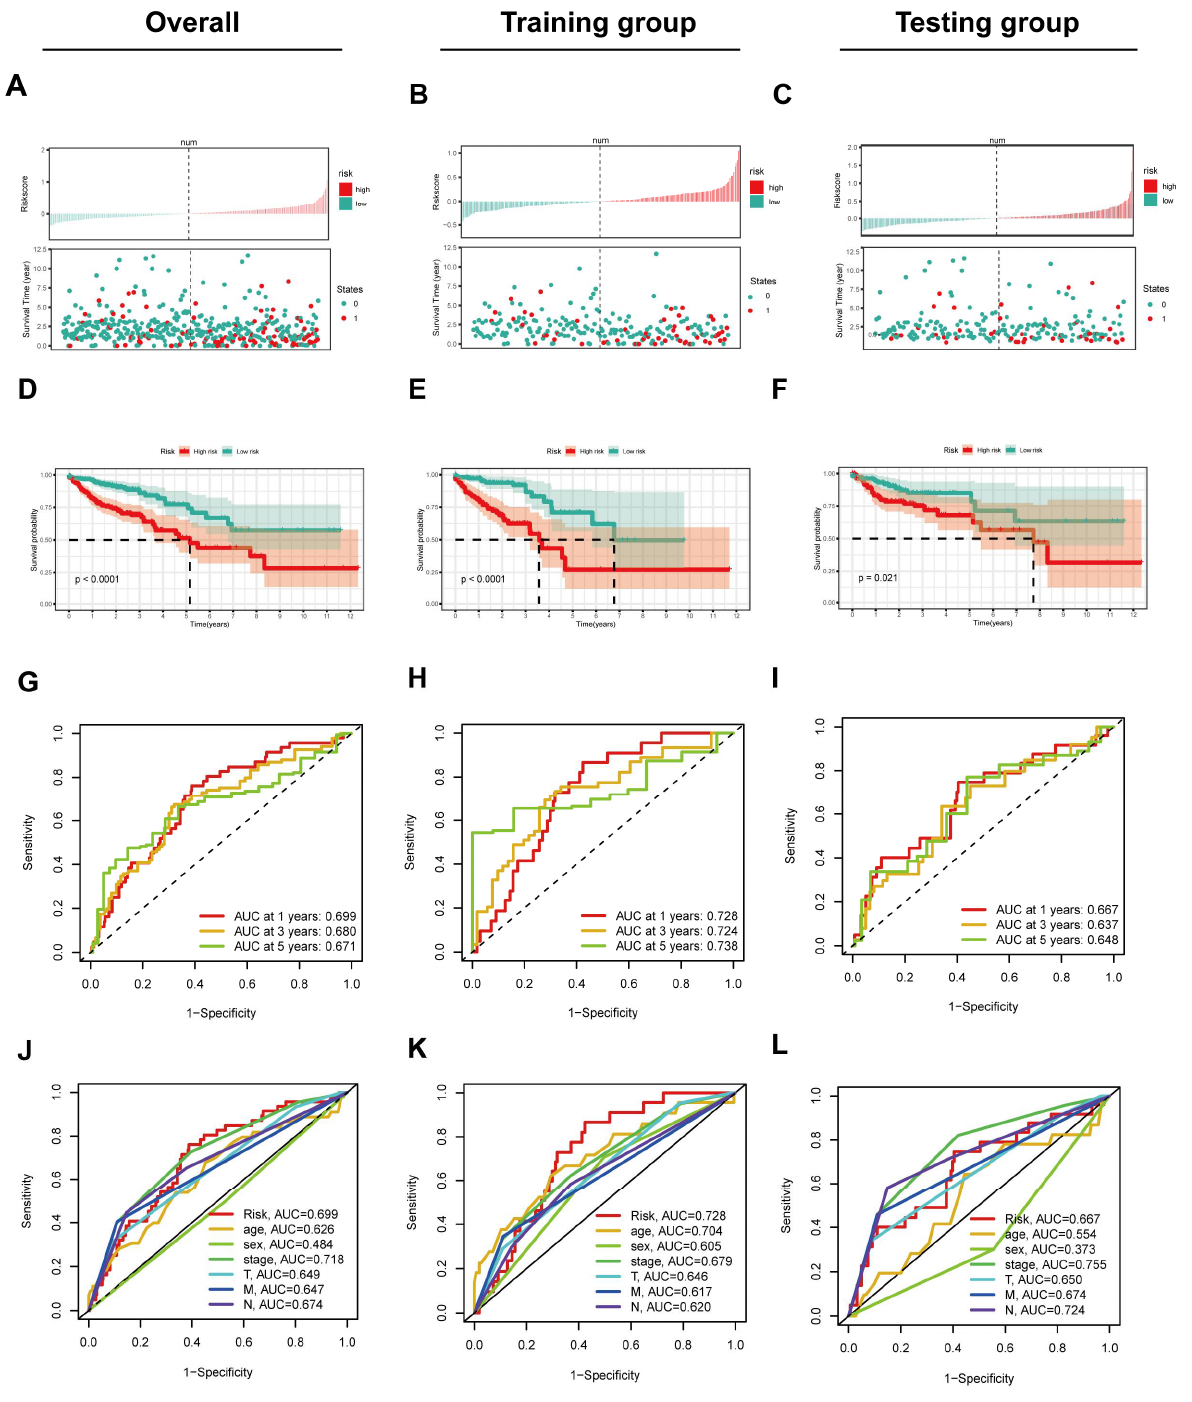
Figure 4. Validation of the necroptosis-related lncRNA model in the overall groups, the training group and the testing. ( A – C ) The distribution of the risk scores and the distributions of OS status in the overall, training and testing groups. ( D – F ) The K–M curves for overall survival in the overall, training and testing groups. ( G – I ) The ROC curve illustrates the prognostic value of the necroptosis-related lncRNA model in predicting the 1-, 3-, and 5-year OS rates in the overall, training and testing groups. ( J – L ) The ROC curve shows the prognostic value of the model and that of other clinicopathological factors in the overall, training and testing groups.